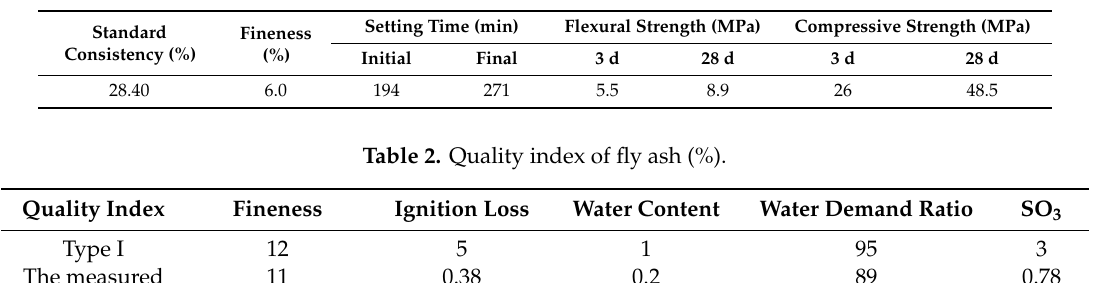
Table 1. Physical properties of cement.